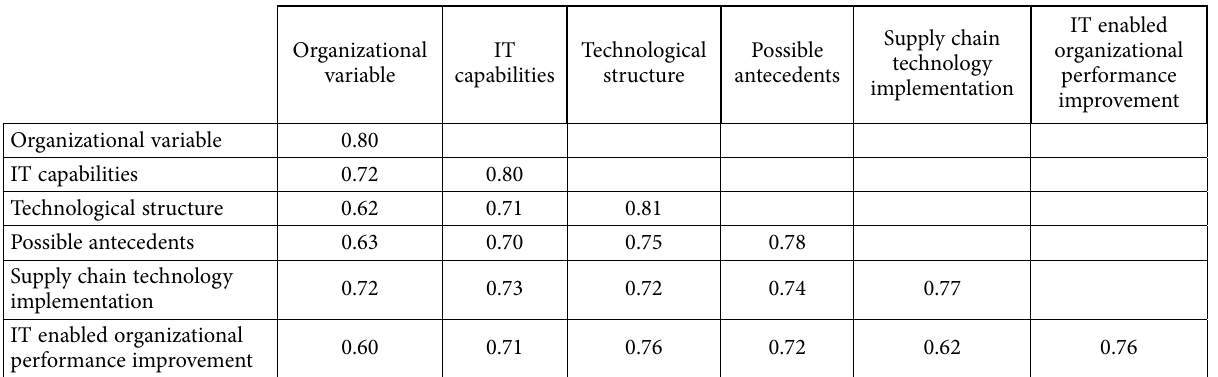
Table 3. Discriminant assessment and correlation matrix